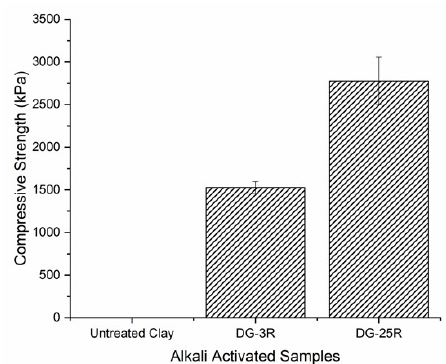
Figure 12. 7-days compressive strength results of alkali-activated samples: S0, DG-3R and DG-25R.